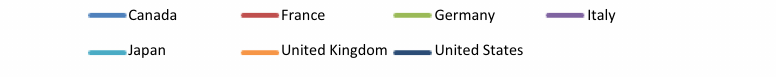
Figure 6. G7 Imports of